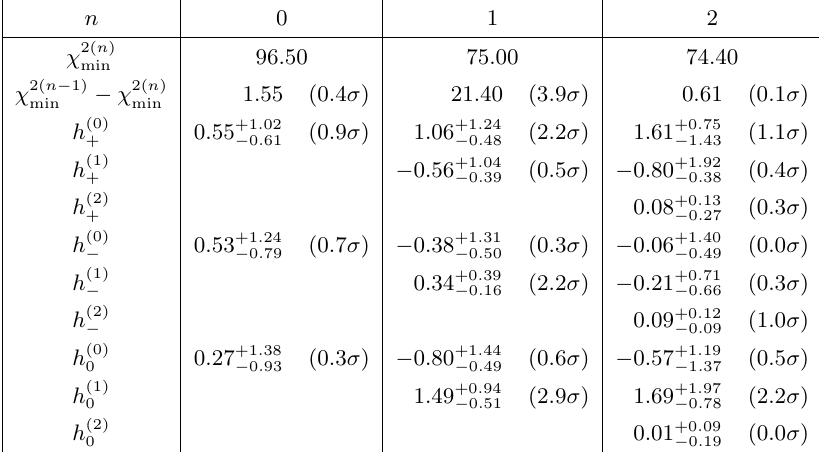
= 0, using the 9 = 98 : 00 for N dof = 81. min; h =0